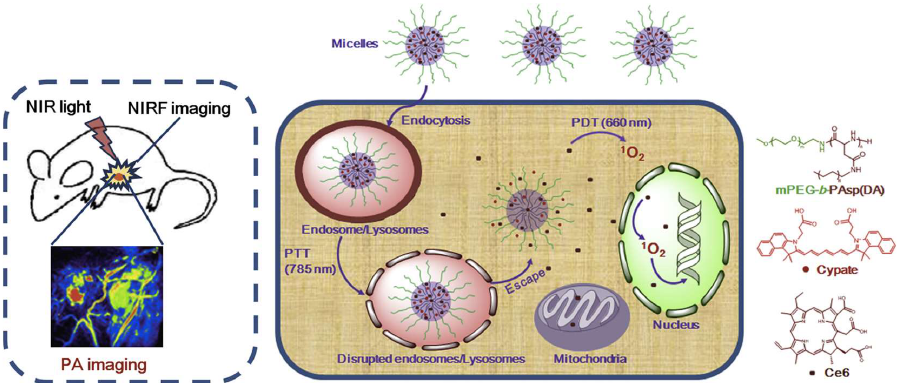
Figure 10. Schematic illustration of Ce6-loaded MPEG- b -PAspDA micelles incorporating cypate